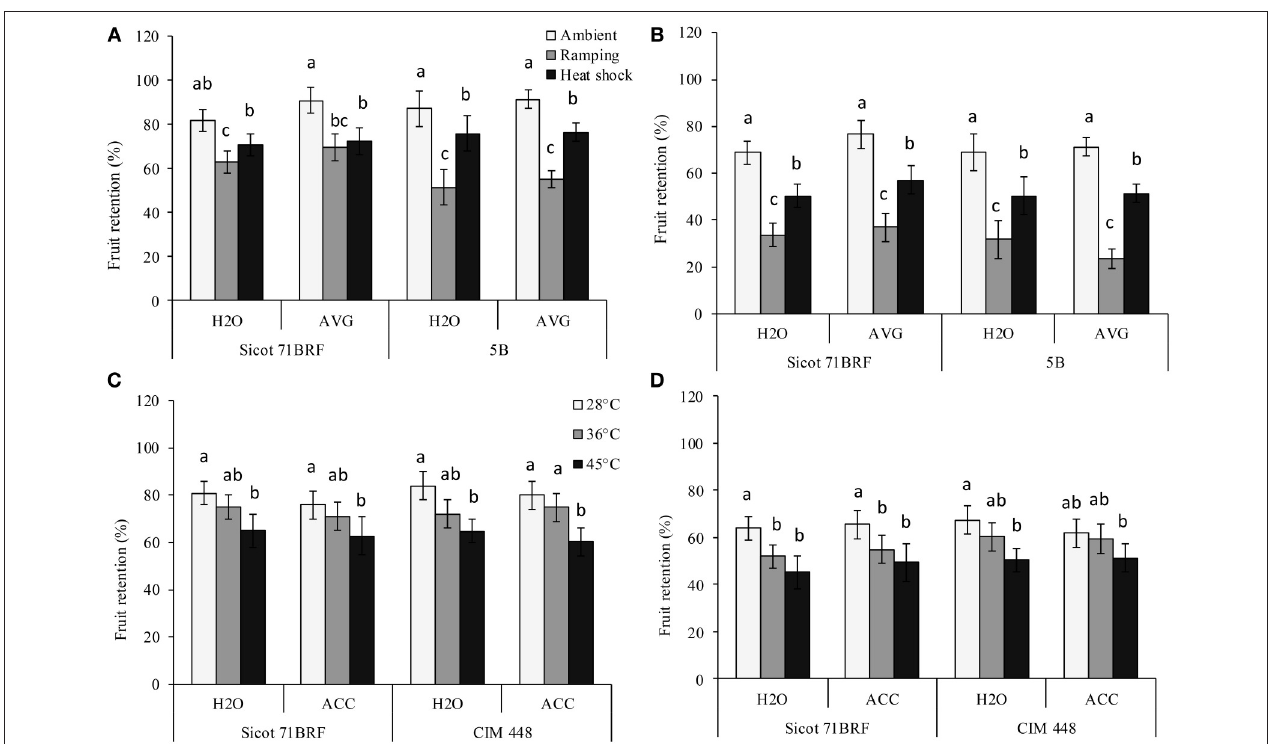
FIGURE 3 | Effect of aminoethoxyvinylglycine (AVG) on fruit retention in cotton genotypes Sicot 71BRF and 5B exposed to heat shock (45 ◦ C) and ramping heat (gradual rise in temperature to 45 ◦ C) for 7 days. Data were collected (A) on the last day of heat treatment and (B) 15 days of recovery after the heat treatment. Values are the mean of four independent replications, with the error bars representing SE and sample size = 4. Effect of 1-aminocyclopropane-1-carboxylic acid (ACC) on fruit retention in cotton genotypes Sicot 71BRF and CIM 448 exposed to heat shock (45 and 36 ◦ C) for 7 days. Data were collected (C) on the last day of heat treatment and (D) 15 days of recovery after the heat treatment. Values are the mean of four independent replications, with the error bars representing SE and sample size = 4. Means sharing same letters within each figure are not significantly different at α =